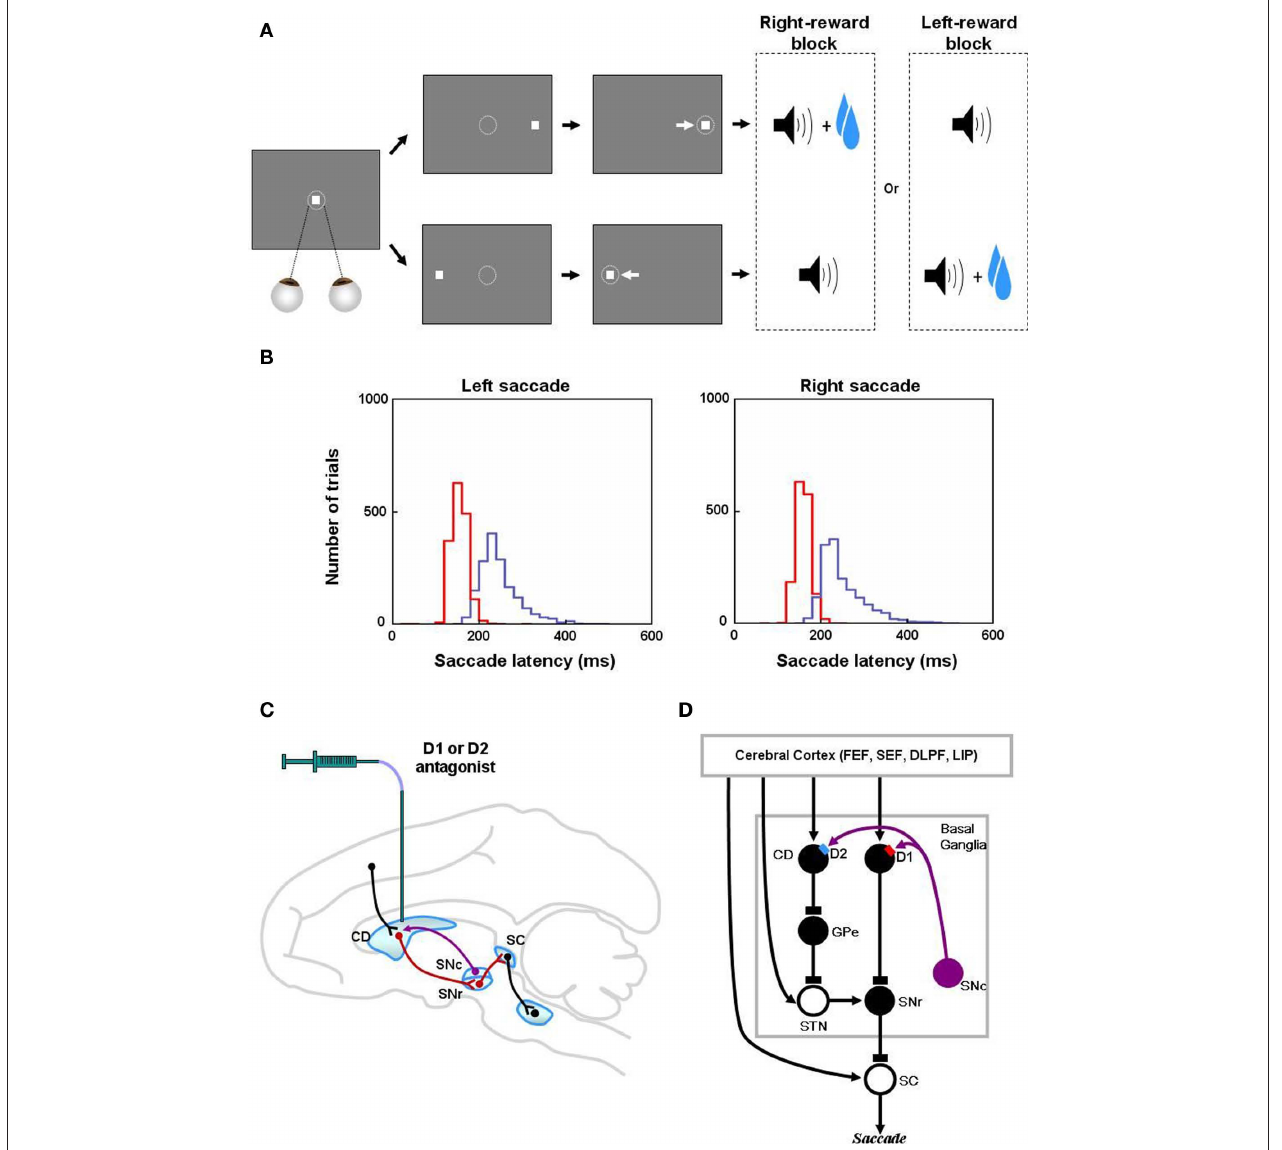
involving D1 and D2 mediated plasticities. D1 and D2 mediated plasticities in direct and indirect pathways are assumed to contribute to eye movements. The purple arrows indicate dopaminergic modulatory connections. The lines with rectangle ends indicate inhibitory connections. Arrow ends indicate excitatory connections. Figures (A) and (B) are from Hong and Hikosaka (2008). Abbreviations: CD, caudate nucleus; D1, D2, D1, and D2 receptors; SC, superior colliculus; SNc/SNr,